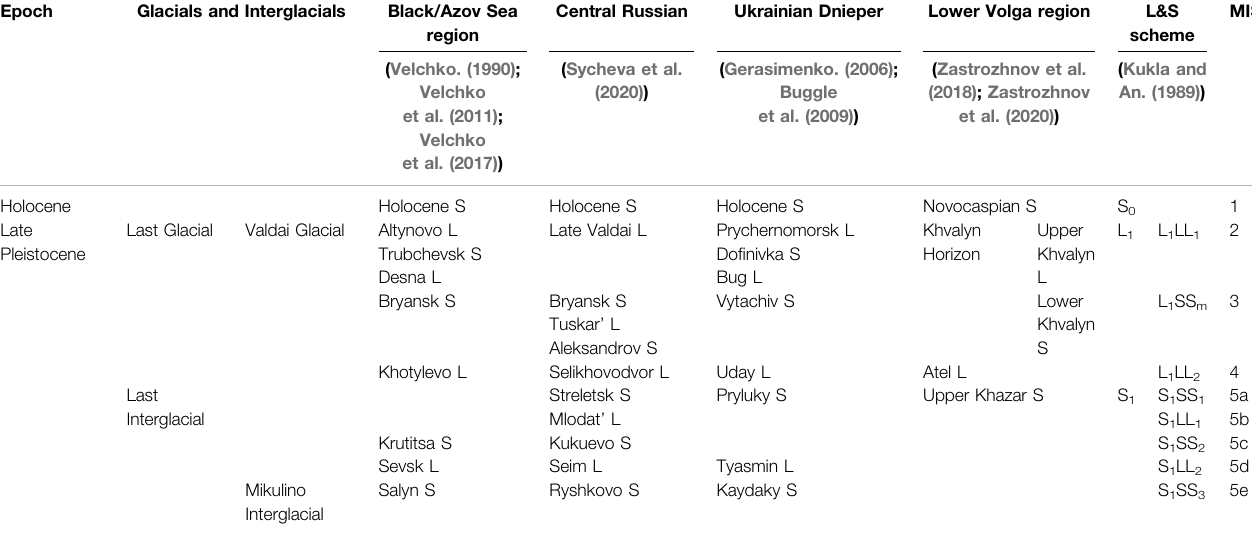
TABLE1| ExistingloessstratigraphicmodelswithdifferentnomenclaturesontheEastEuropeanPlainandcorrelationswithL&S(loessandsoil)stratigraphicnomenclatures initially presented by Kukla and An (1989) and marine isotope stages (MISs) since the Late Pleistocene. Epoch Glacials and